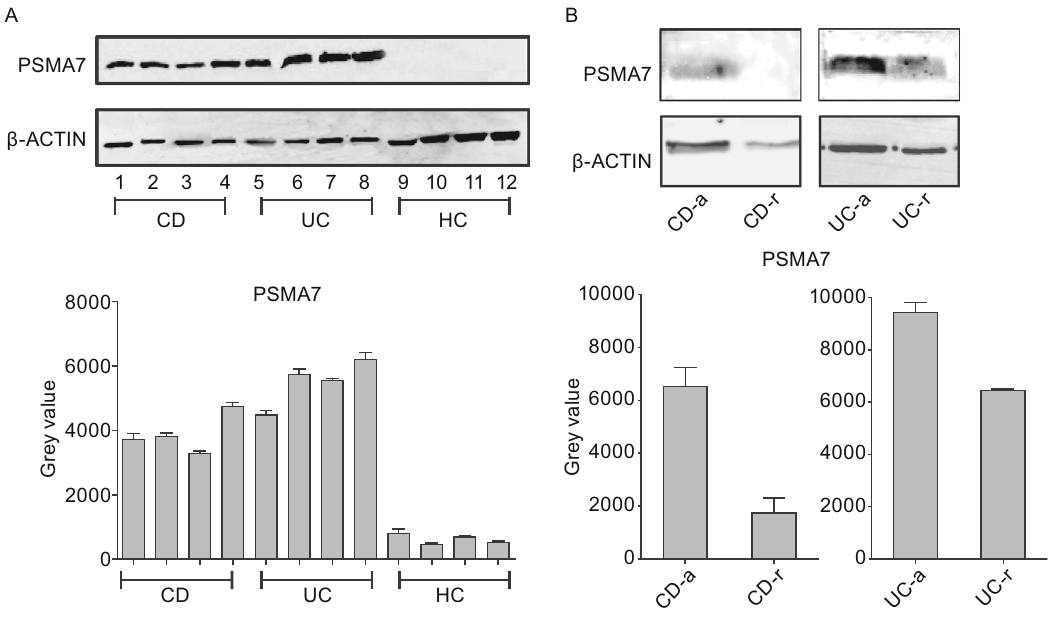
Figure 4. Veri fi cation of PSMA7 in salivary exosomes. (A) Salivary exosomal PSMA7 levels were detected by Western blotting among HC, CD, and UC groups. And PSMA7 exists mostly in CD and UC patients. (B) Salivary exosomal PSMA7 levels were detected in CD-active, CD-remission, UC-active, UC-remission patients. The result shows expression of PSMA7 reduced a lot in patients who are in the remission